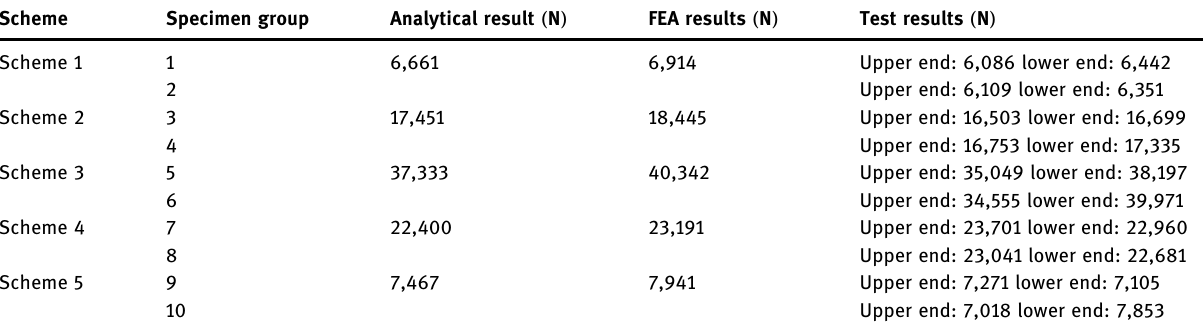
Table 8: Sensitivity study on the maximum assembly force under the interference fi t joints Scheme